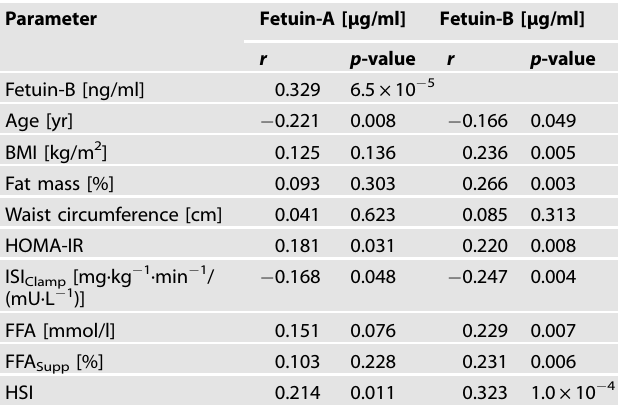
parameters with Fetuin-A and B.